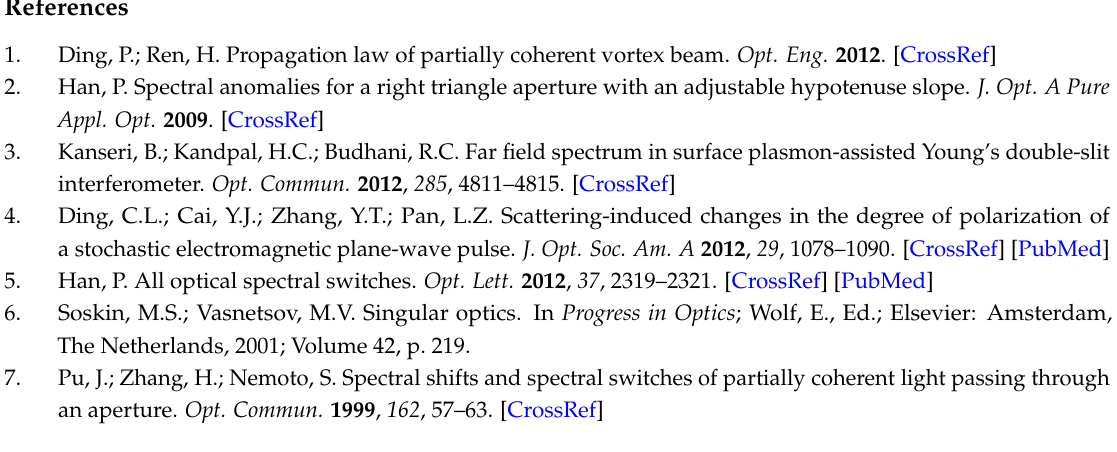
Figure 9. ( a ) The schematics for a digital data transmission scheme with polarization control; ( b ) Using Ag for transmission task at arbitrary angle θ to the right of vertical direction (V); ( c ) Only the direction near Brewster angle can be used for that purpose with water.